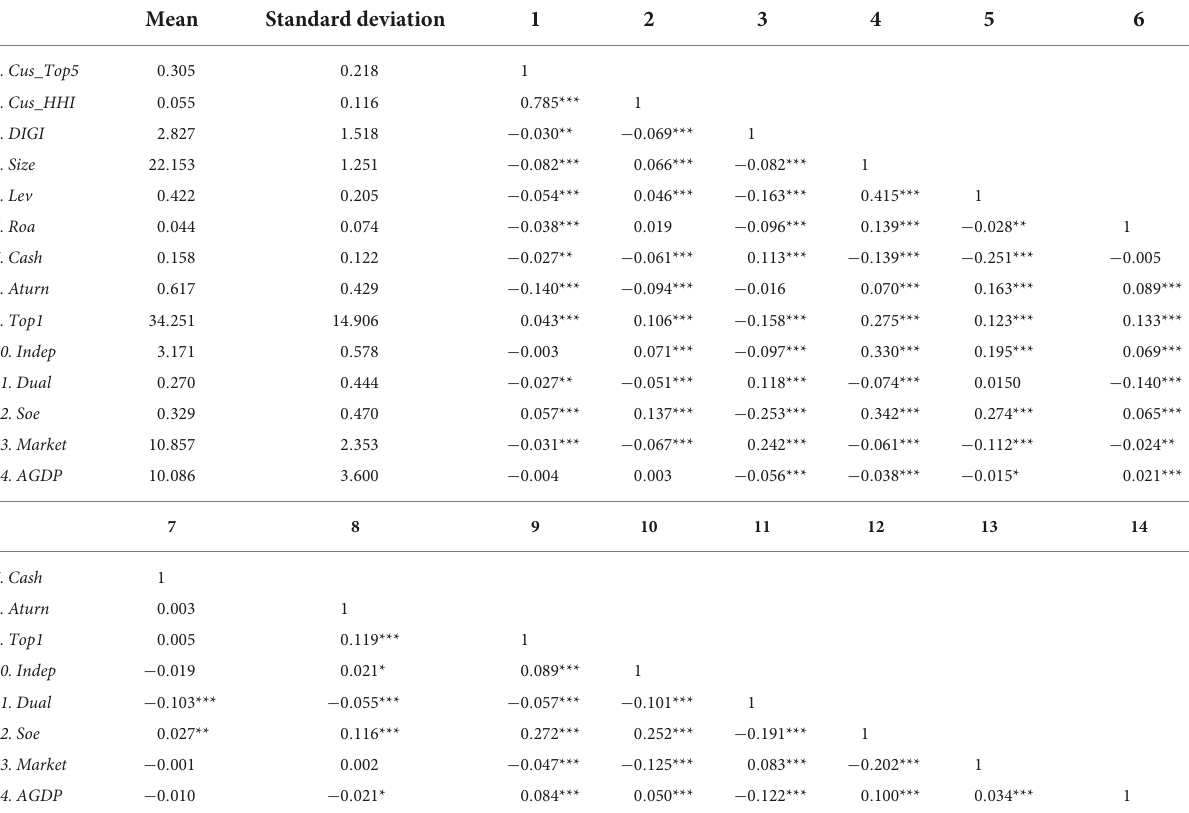
TABLE 3 Descriptive statistics and correlation coefficient